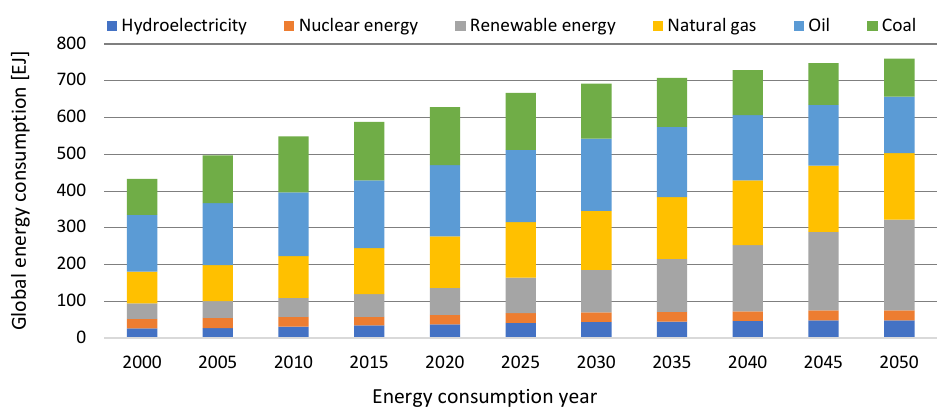
Figure 4. Global energy consumption (2000–2019) and a forecast until 2050 [27].